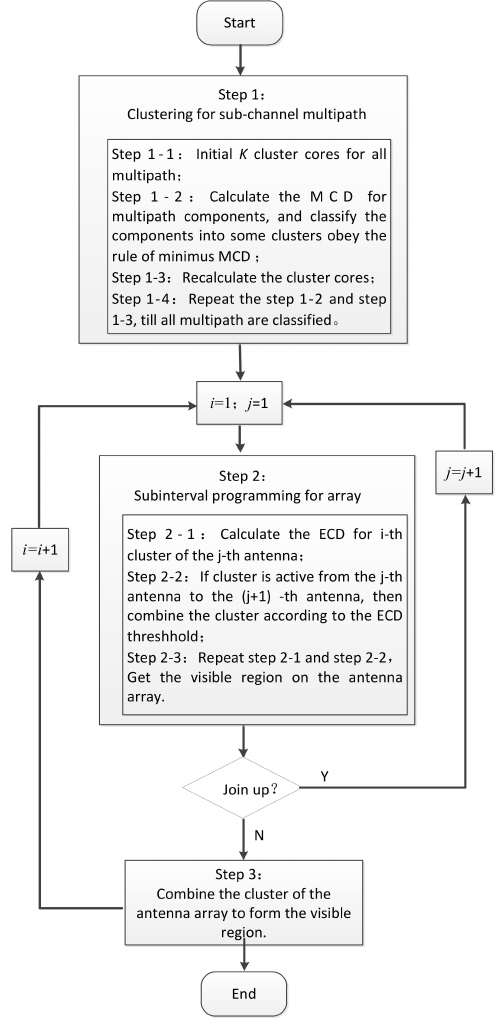
Figure 6. Flow chart of clustering and subinterval programming